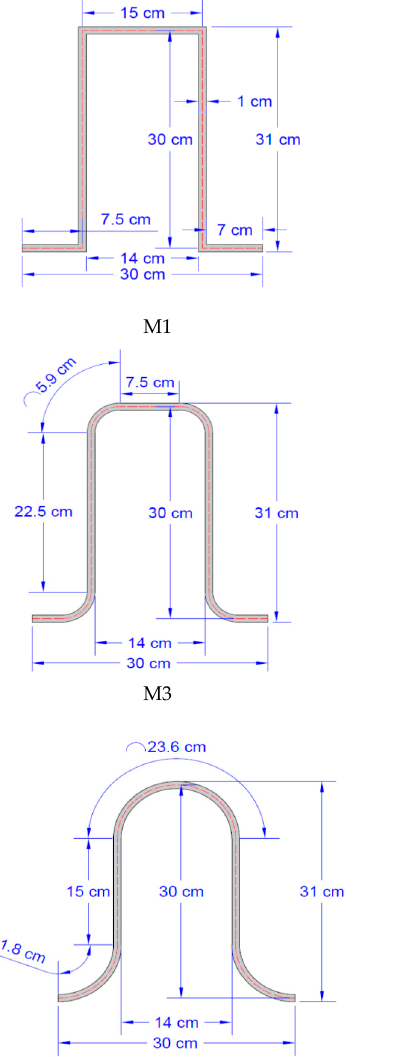
Table 2. Detail of the experimental runs.